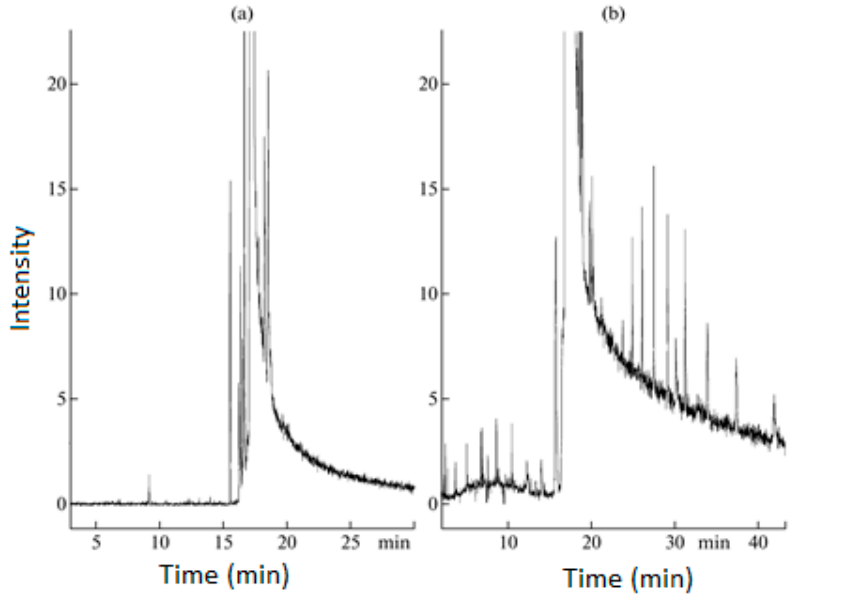
Figure 6. Chromatograms of ( a ) initial hexadecane and ( b ) hexadecane subjected to treatment in an ultrasonic cavitation unit [54].